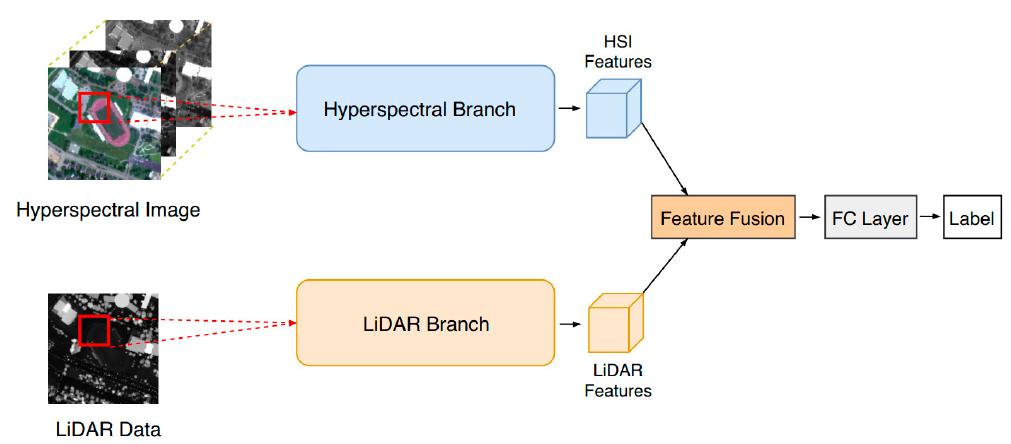
Figure 2. Architecture of the proposed two-branch convolutional neural network.